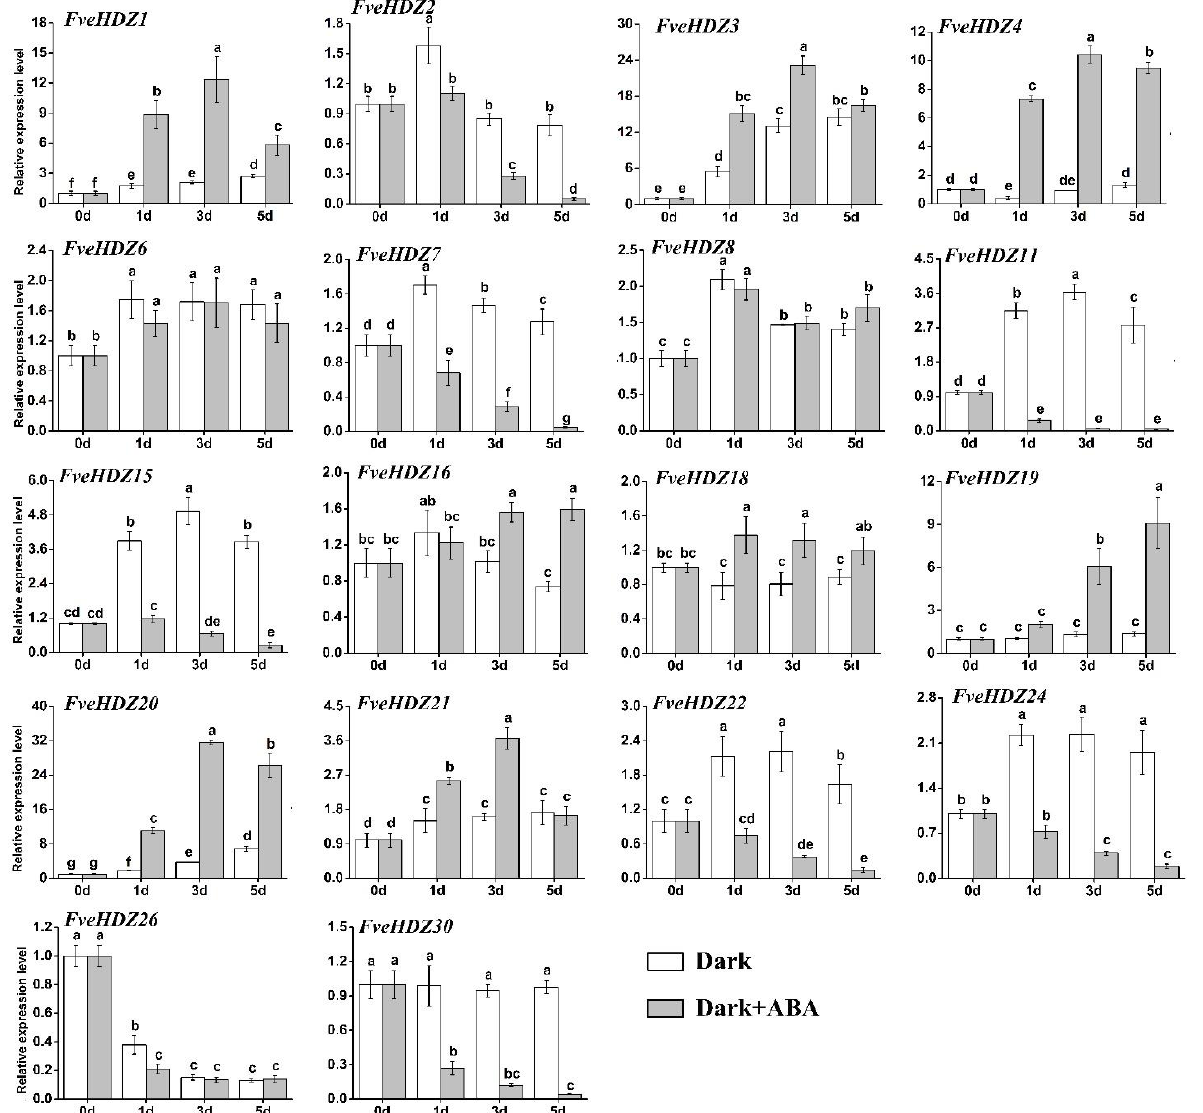
Figure 5. Relative expression levels of FveHDZs in the leaves in dark treated with (grey columns) or without (white columns) ABA. Expression at 0 d was normalized as “1” for each gene. Data were shown as mean ± standard deviation derived from three biological replicates, and different letters above the bars indicate significant differences based on Duncan’s multiple range tests ( p < 0.05, n =